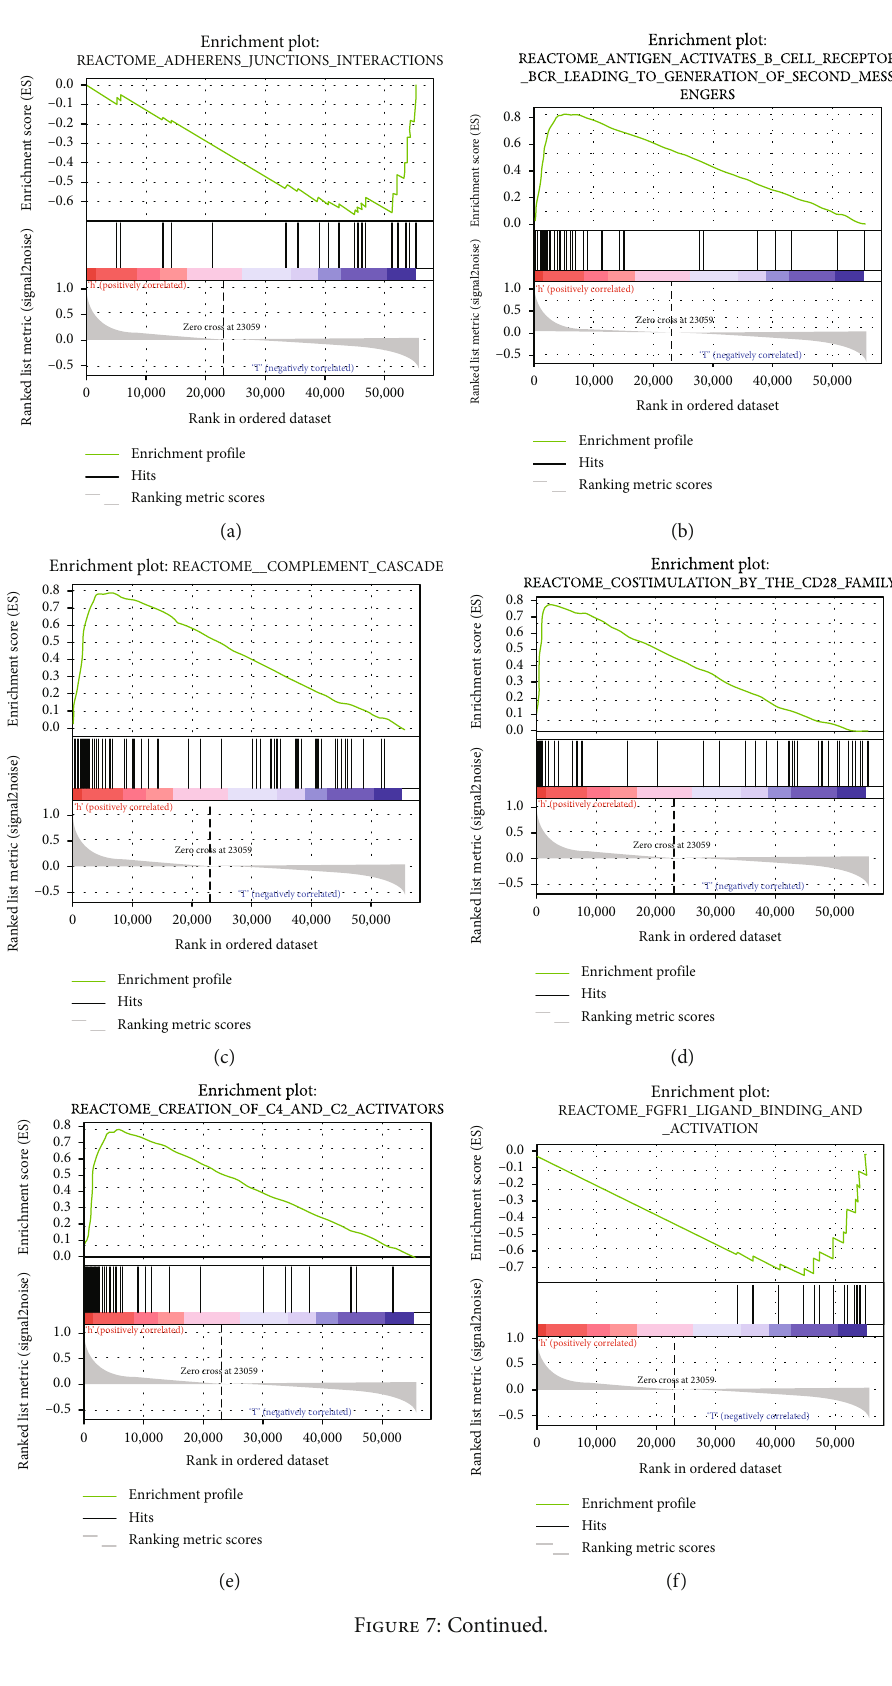
Enrichment plot: